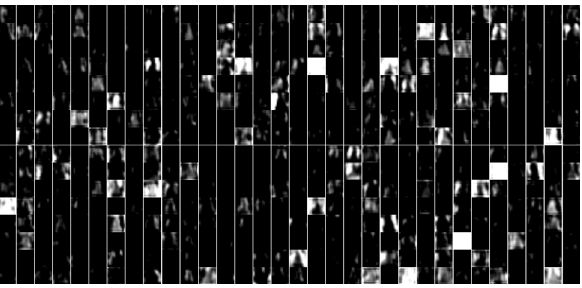
Fig. 10 These are the 512 feature maps extracted from the last convolutional layer of the VGG16 model. In transfer learning, we adopt a previously trained CNN model on current data set (i.e. pneumonia data). Due to lack of feature assessment procedure, we expect many of these feature maps to be inexplainable to detect the disease cases which are noisy information that do not contribute to a robust prediction performance. The motivation is to generate a robust understanding which features can explain the prediction performance.